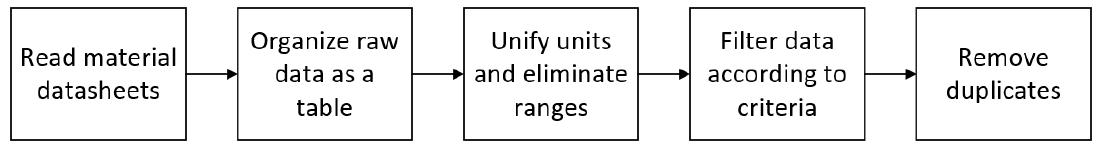
Figure 2. Overview of the data filtering